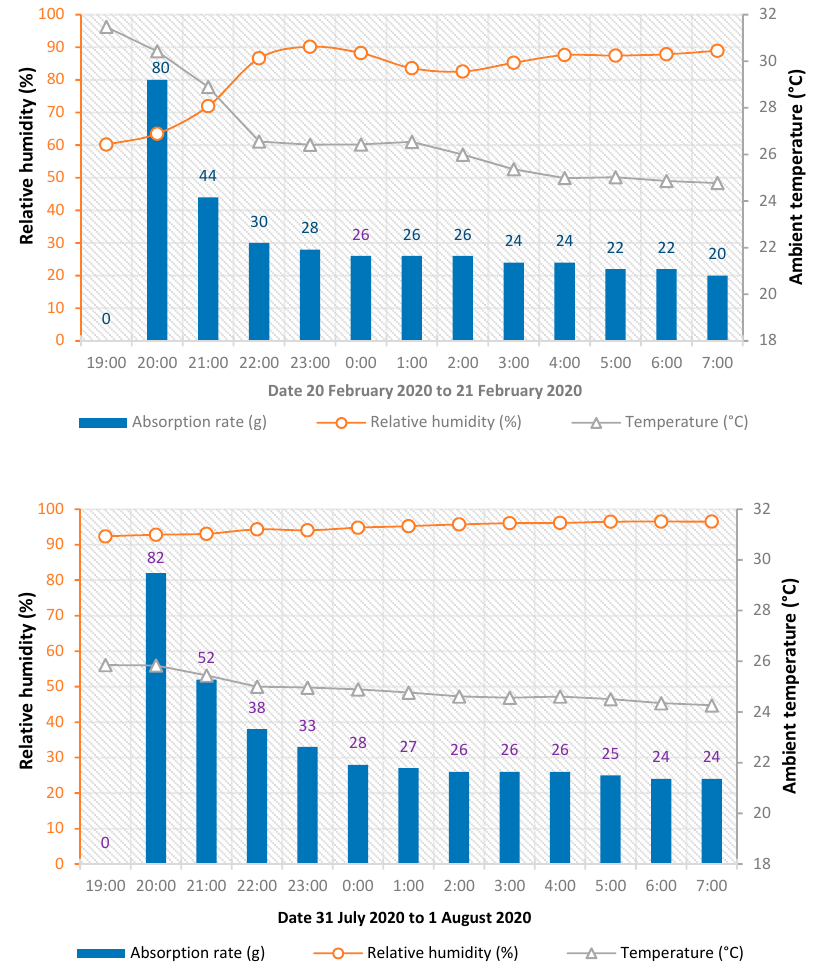
Figure 9. Adsorption rate, ambient air temperature and relative humidity.